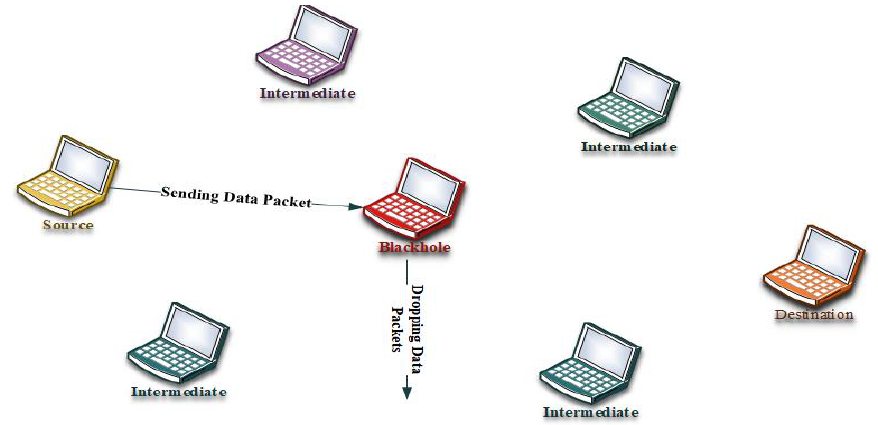
Figure 1. Packet drop by black hole node.